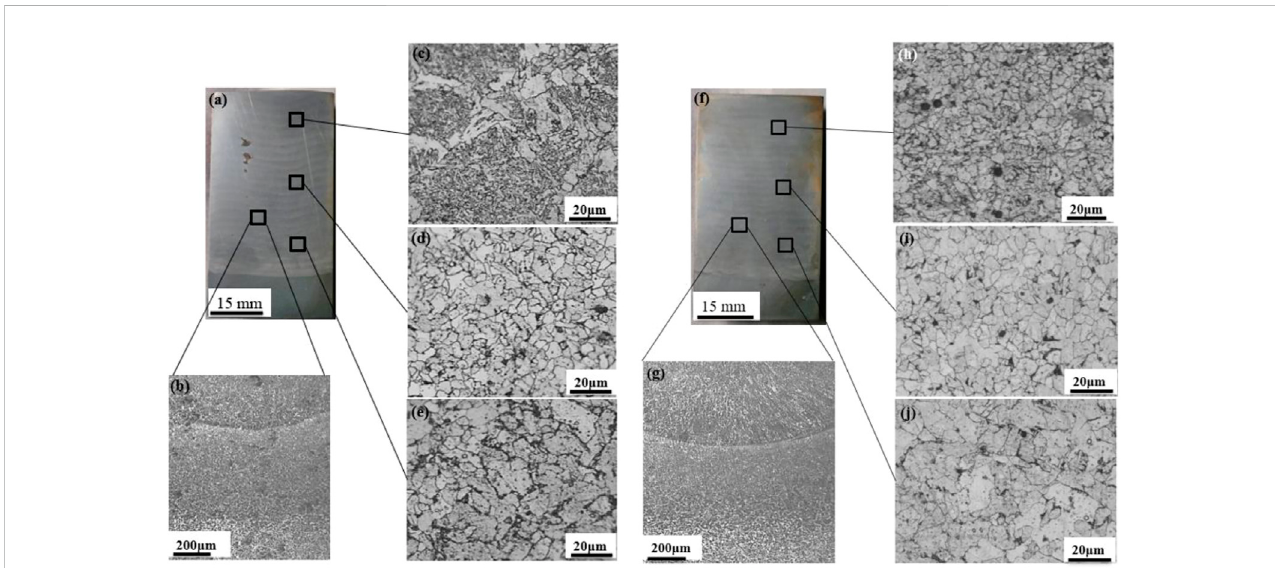
FIGURE 8 (A) Etchedsampleproducedwithoutcooling; (B) microstructureofcylinderwithoutcooling; (C) acicularferrite( α a )alongwithbainiteregionsadjacentto the melt-pool boundary; (D) Typical polygonal ferrite; (E) Low-volume fraction of the lamellar pearlite phase, which has primarily formed along the ferrite grain boundaries. (F) Etched sample produced with cooling, (G) Microstructure of ER70S-6 cylinder with cooling, (H) fi ne polygonal ferrite (F) and a low- volume fraction ofthe lamellarpearlite(P) along thenewly depositedlayer (LayerN) and HAZ, (I) medium polygonalferrite(F)and alow-volumefraction of the lamellar pearlite (P) in the HAZ, (J) Coarse polygonal ferrite along the old, deposited layer (Layer N-1) and